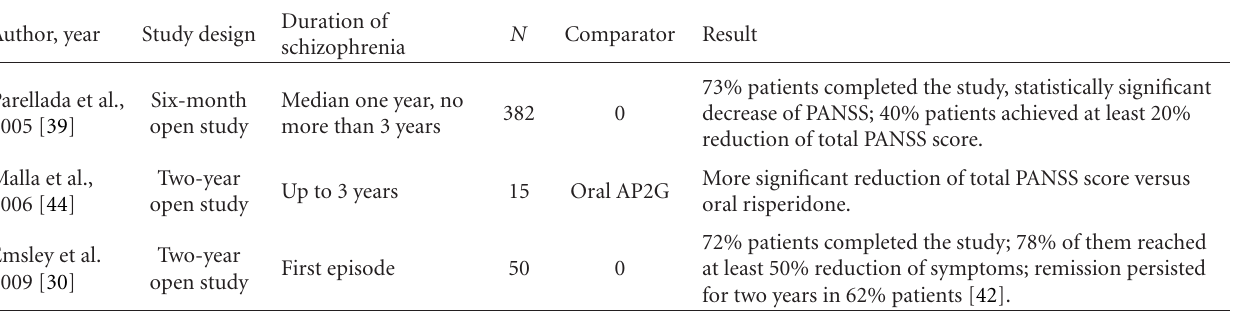
Table 1: Survey of studies on LAI risperidone in first-episode schizophrenia